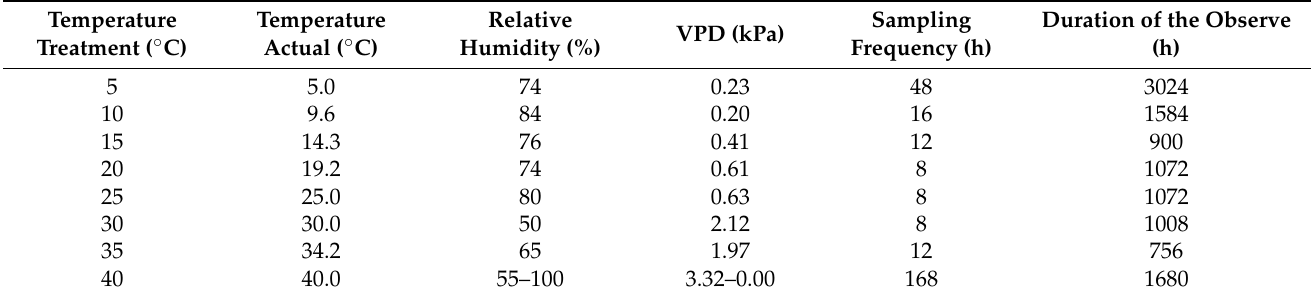
Table 2. Temperatures, relative humidity and vapor pressure deficit (VPD) measured for